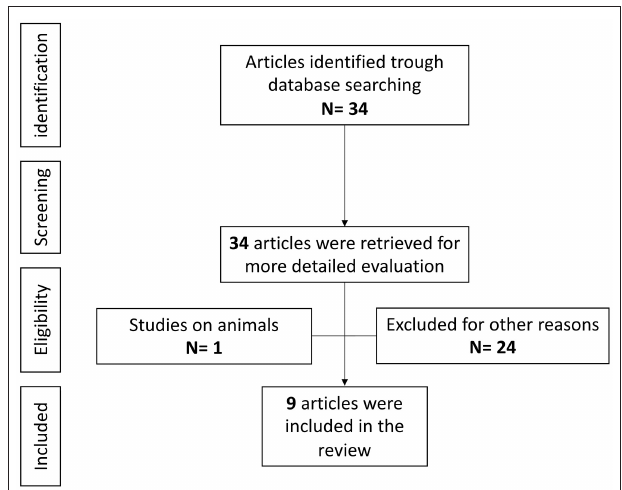
FIGURE 4 | Anti-IL-6 agents and epilepsy, literature